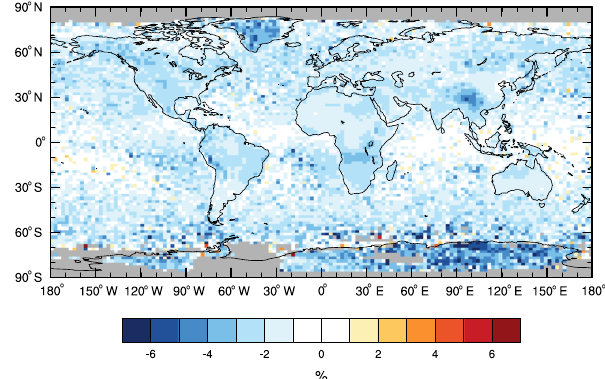
Figure 6. Relative difference (%) between simulated (E2005) and SCIAMACHY annual column-averaged methane concentrations. Relative difference = 100 × ( model − satellite )/ satellite. Range = − 11 . 2% to + 7 . 1%.